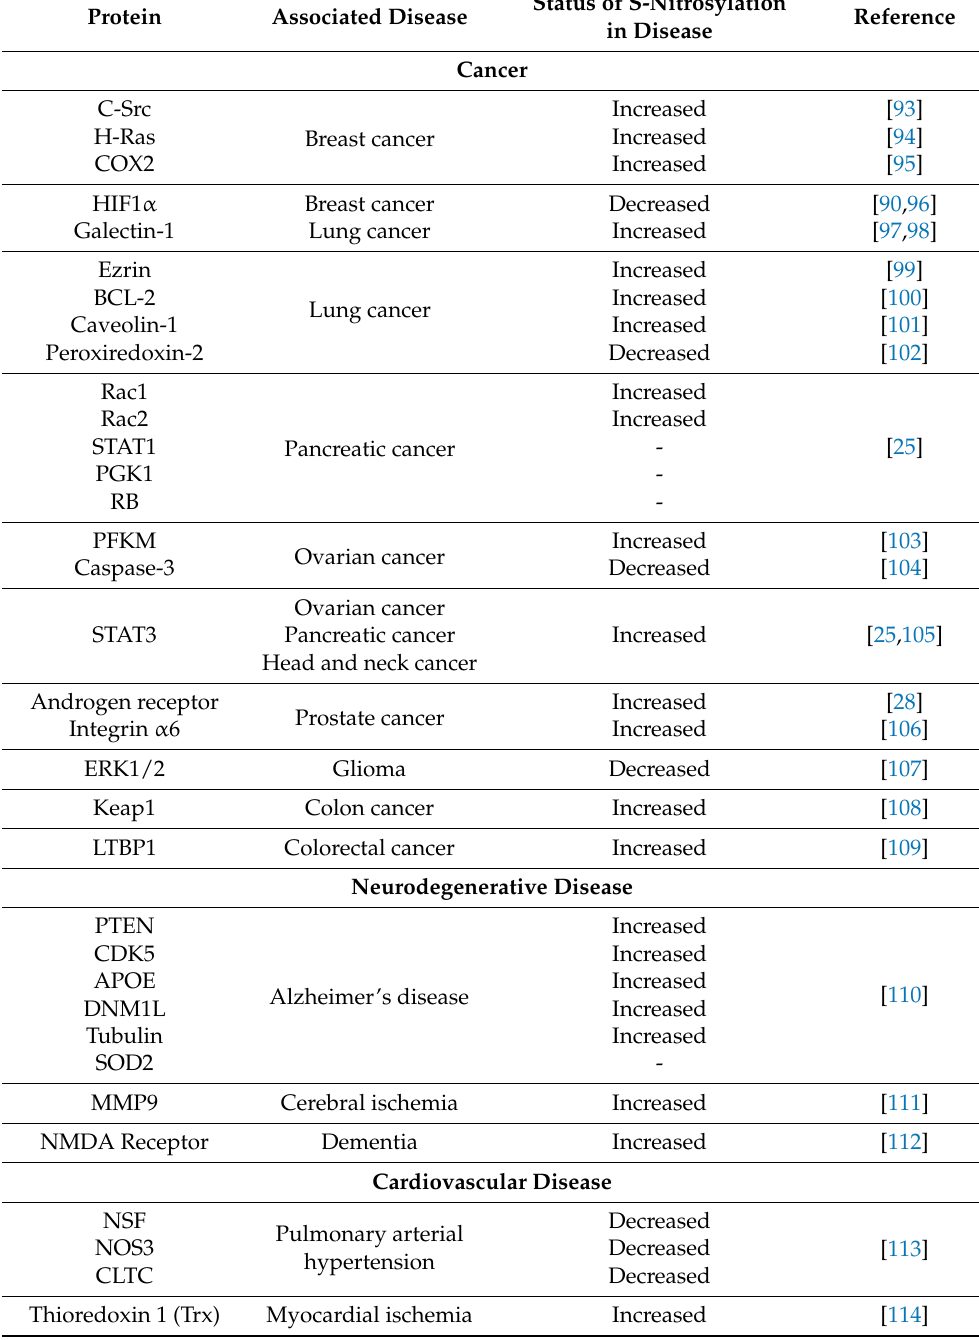
Table 1. S-nitrosylated proteins linked to different